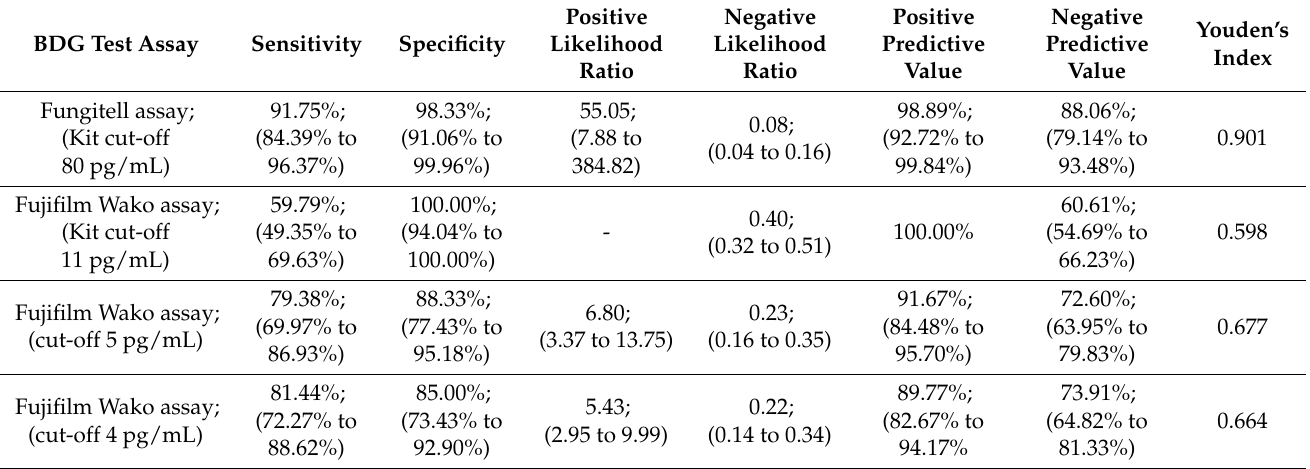
Table 1. The diagnostic performance characteristics of the Fungitell assay at the